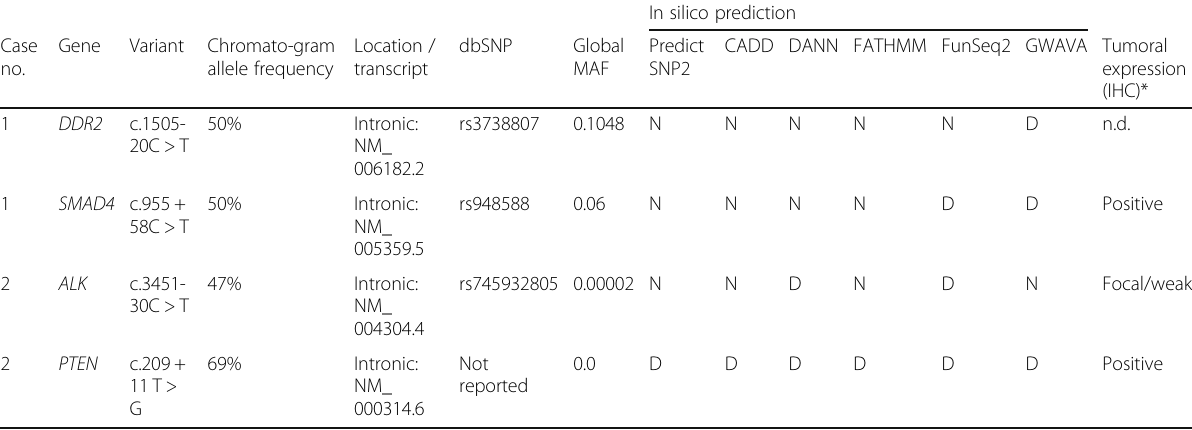
In silico prediction